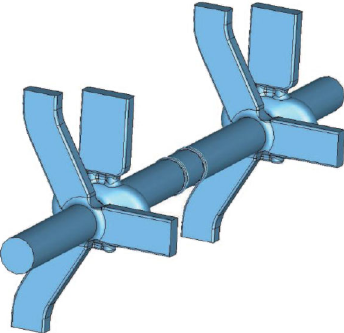
FIG. 15. The two-cavity model used to investigate the wakefield couplingbetweencavities.The intervalbetweencavities